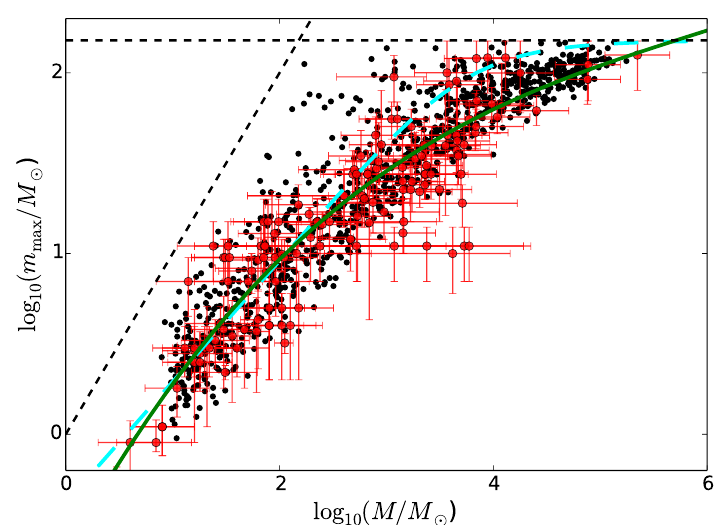
Fig.2. Sample of the masses of the most massive stars vs. the masses of their host clusters from Weidner et al. (2013, red points), compared with the artificial star cluster distribution of 1000 models (black points) built using the RRS method with the calibrated expansion factor P = 6 and the correction parameter d = 0 . 2 (see Section 3 for details on the parameter d ) and adding the errors of the same magnitude as for observations. The cyan long-dashed line is the theoretical relation derived by Kroupa et al. (2013) and the green solid line is a third order polynomial fit to the data of Weidner et al. (2013). The oblique black dashed line is a one-to-one relation between the mass of the most massive stars and the mass of their host clusters, m max = M , and the top black dashed line is the upper physical stellar mass limit, 150 M (cid:12)